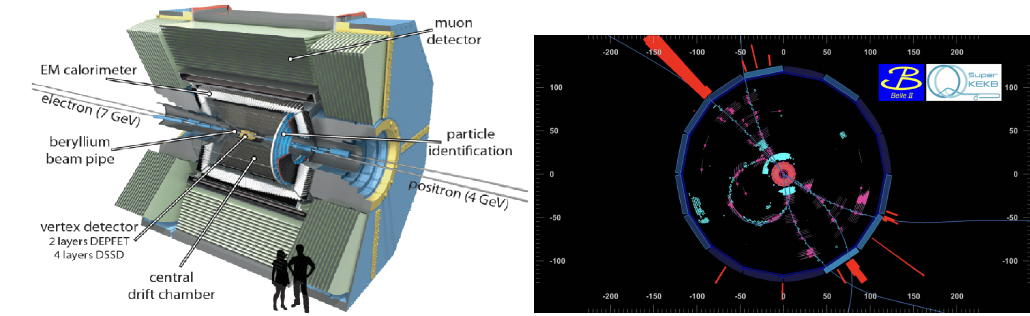
Figure 1. Schematic view of the Belle II detector (Left) and first Phase-3 data recorded events [16]